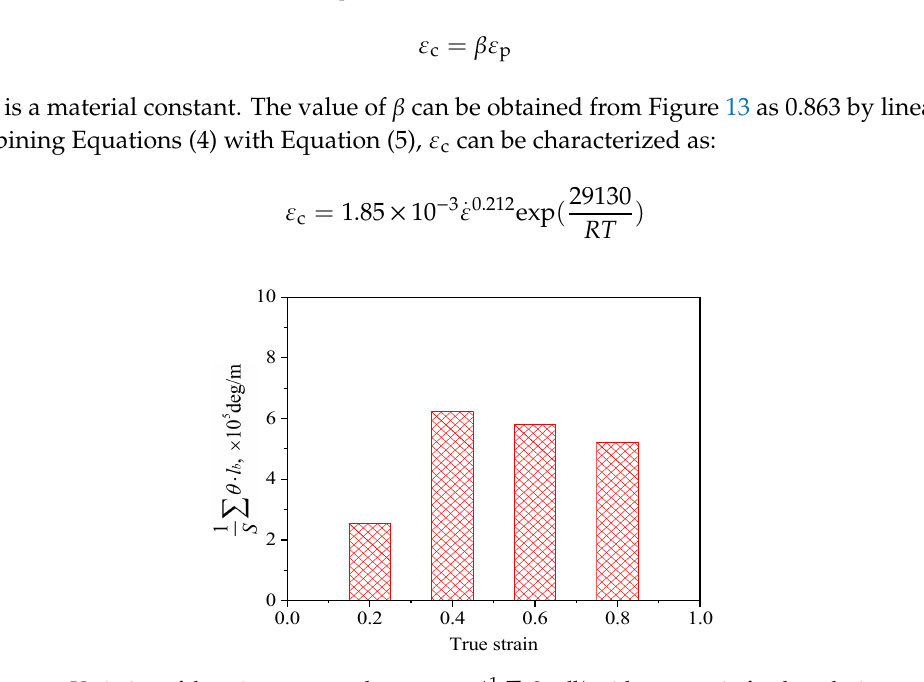
Figure 10. Variation of the microstructural parameter ( solution-treated samples deformed at 900 ° C and 10 − 3 s − 1 .